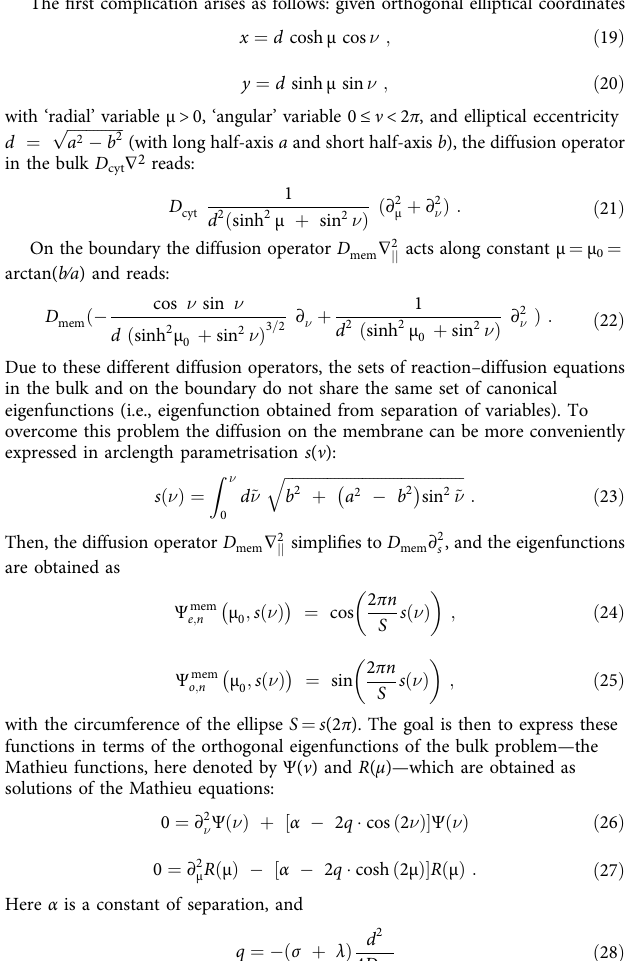
Table 2 FEM sample sweeps of k Ap , k Pa with small initial